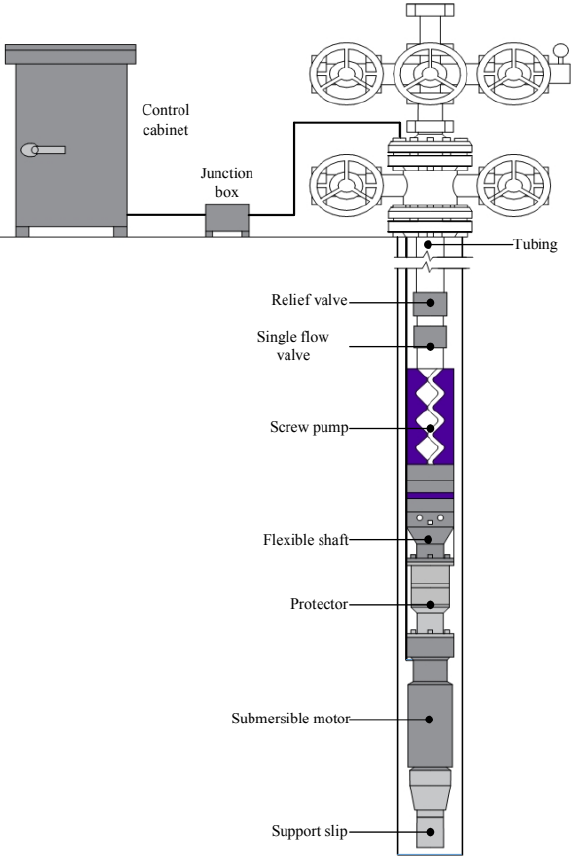
Fig. 1. Schematic diagram of production system with submersible screw